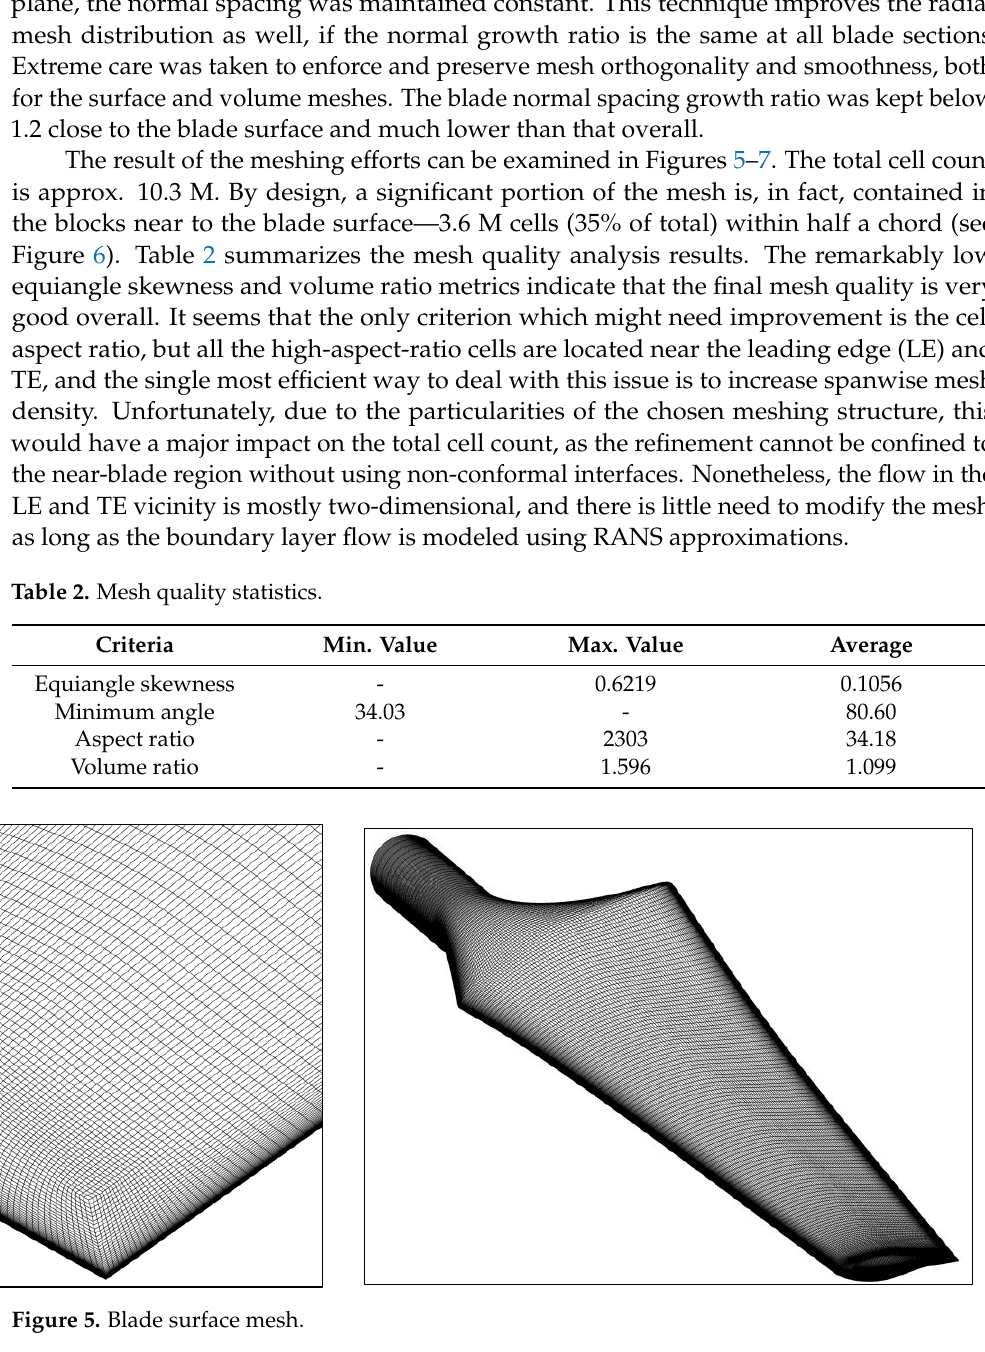
Figure 6. Volume mesh section normal to the blade pitch axis at r/R = 0.95. Figure 7. Volume mesh longitudinal section (through rotational axis).